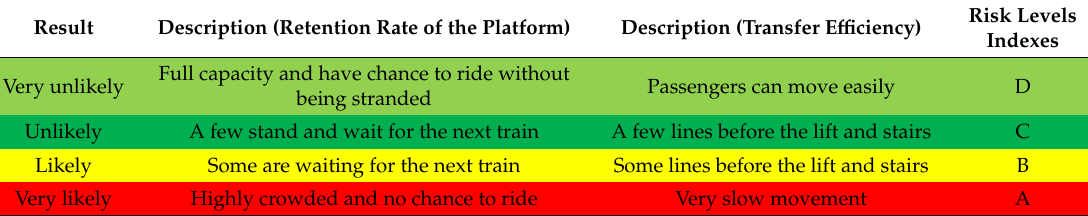
Table 3. Scale of the level of the risk probability (green: low risk; yellow; moderate risk; red: high risk).